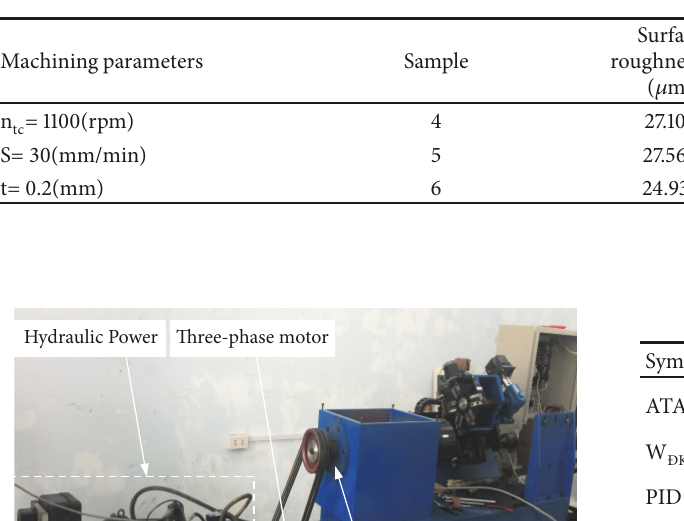
Table 9: Surface roughness results for samples 4, 5, and 6.